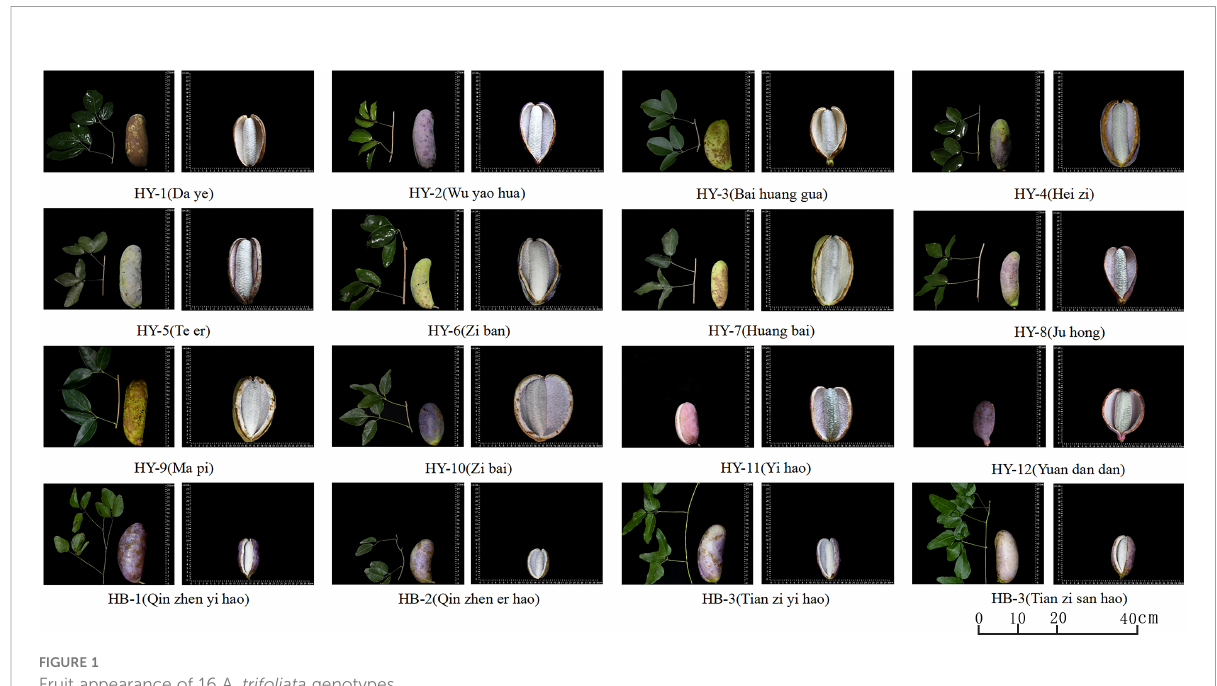
FIGURE 1 Fruit appearance of 16 A . trifoliata